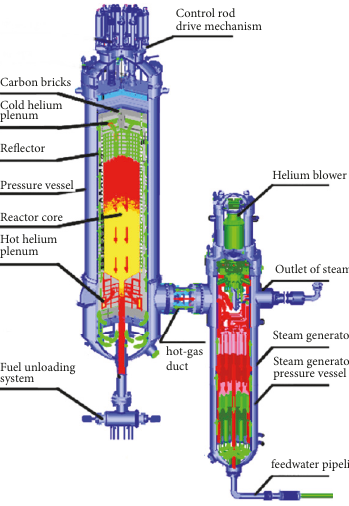
Figure 1: Illustration of the